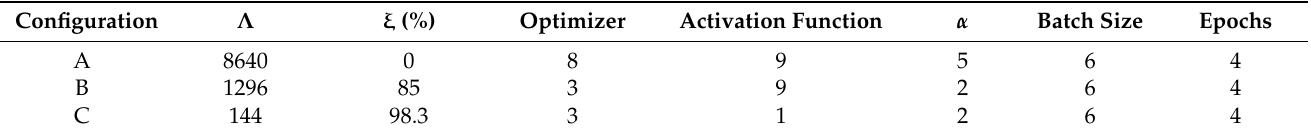
Table 2. Hyperparameter search space combination